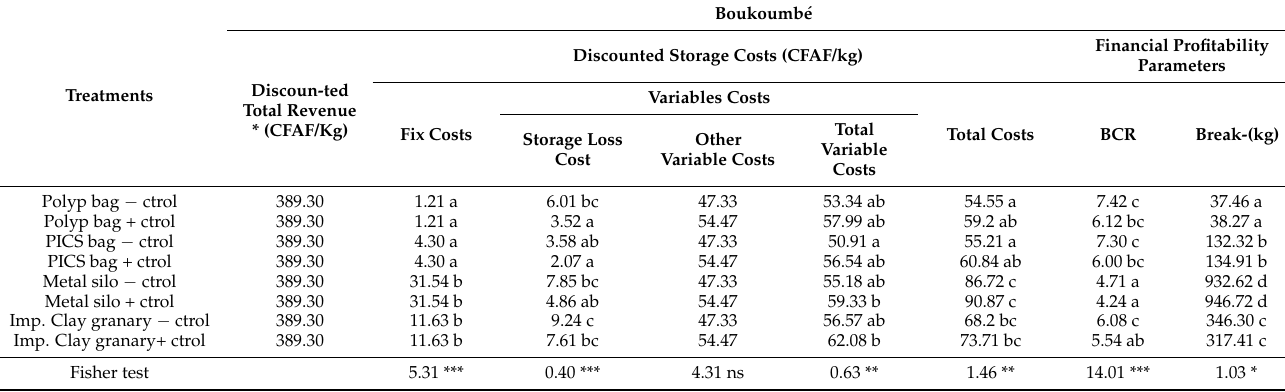
Table 4. Benefit–cost ratio and break-even quantity of the different treatments implemented in Boukoumb é .